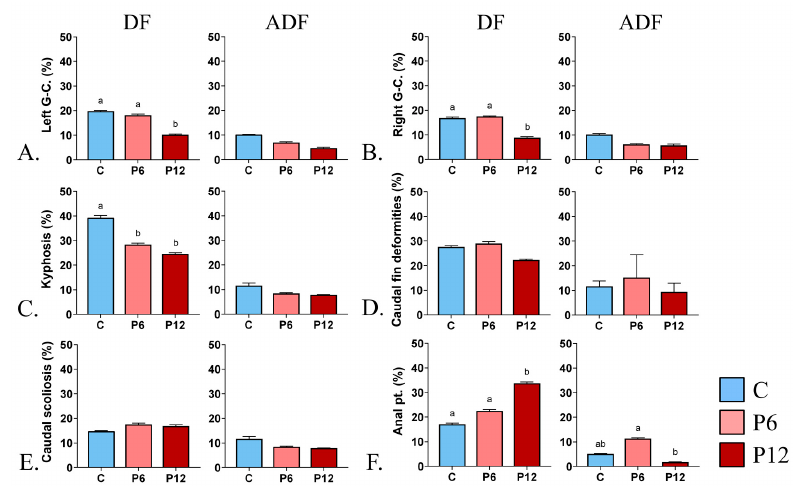
Figure 4 . Main skeletal abnormality types observed at the end of larval rearing in zebra fi sh fed with the experimental diets (C, P6, P12) according to the two feeding regimes (DF, ADF). ( A , A ′ ) Angled view of the abnormal gill cover with magni fi cation on the malformed bone, respectively. ( B ) Pre- haemal kyphosis. ( C ) Missing and compressed caudal fi n rays in DF regime. ( D , D ′ ) Unbundling of the caudal fi n lepidotrichia in ADF regime with magni fi cation on the malformed bones respectively (black arrows). ( E ) Scoliosis of the caudal peduncle. ( F ) Disorientated anal fi n pterygiophores (black arrows). Scale bar equals 0.5 mm.